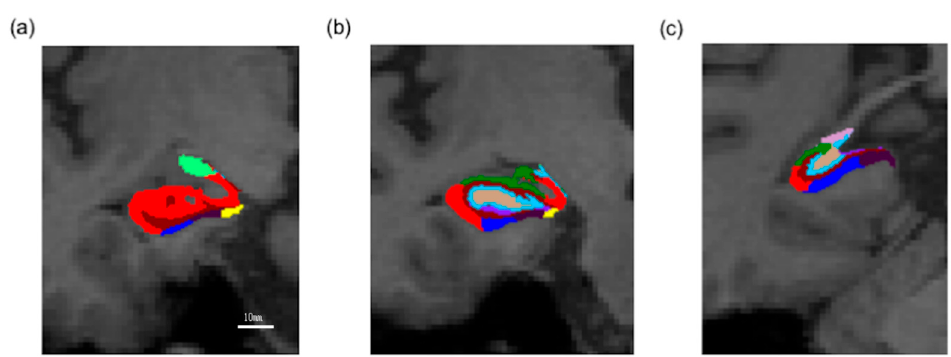
Figure 2. Representative subdivision of the hippocampal subfields. The mask of each region was overlaid on coronal T1-weighted images from anterior ( a ), middle ( b ), to posterior ( c ). Color classification: parasubiculum = yellow; presubiculum = black; subiculum = blue; cornu Ammonis (CA) 1 = red; CA3 = dark green; CA4 = brown; granule cell layer of the dentate gyrus (GC-DG) = sky blue; hippocampus-amygdala transition area (HATA) = green; fimbria = purple; molecular layer of the hippocampus (HP) = dark brown; hippocampal fissure = dark purple; hippocampal tail = gray.